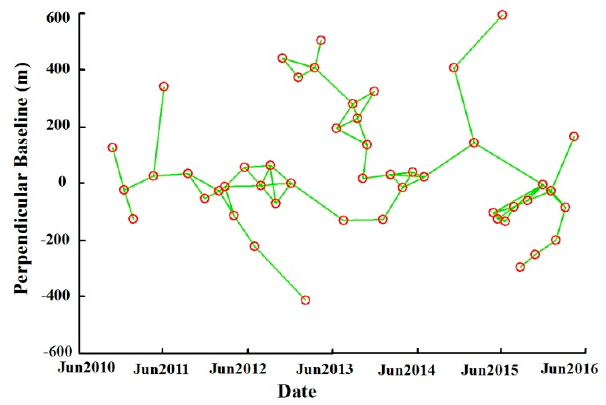
Figure 2. A network of interferogram pairs obtained from TerraSAR-X used in small baseline subset (SBAS) InSAR.